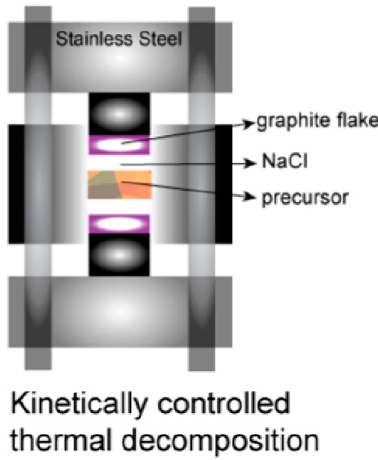
Figure 8. Schematic showing the kinetically controlled thermal decomposition (KCTD) set-up for the preparation of Na 8 Al 8 Si 38 . Reprinted with permission from Dong, Y.K.; Chai, P.; Beekman, M.; Zeng, X.Y.; Tritt, T.M.; Nolas, G.S. Precursor Routes to Complex Ternary Intermetallics: Single-Crystal and Microcrystalline Preparation of Clathrate-I Na 8 Al 8 Si 38 from NaSi plus NaAlSi. Inorg. Chem. 2015 , 54 , 5316–5321 [9]. Copyright (2015) American Chemical Society.